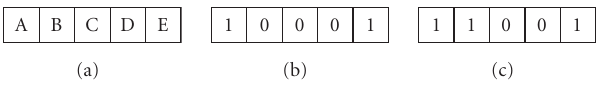
Figure 2: (a) A binary vector indexed by taxa names, (b) a binary representation of the bipartition in Figure 1(b), (c) a binary repre- sentation of the bipartition in Figure 1(c).